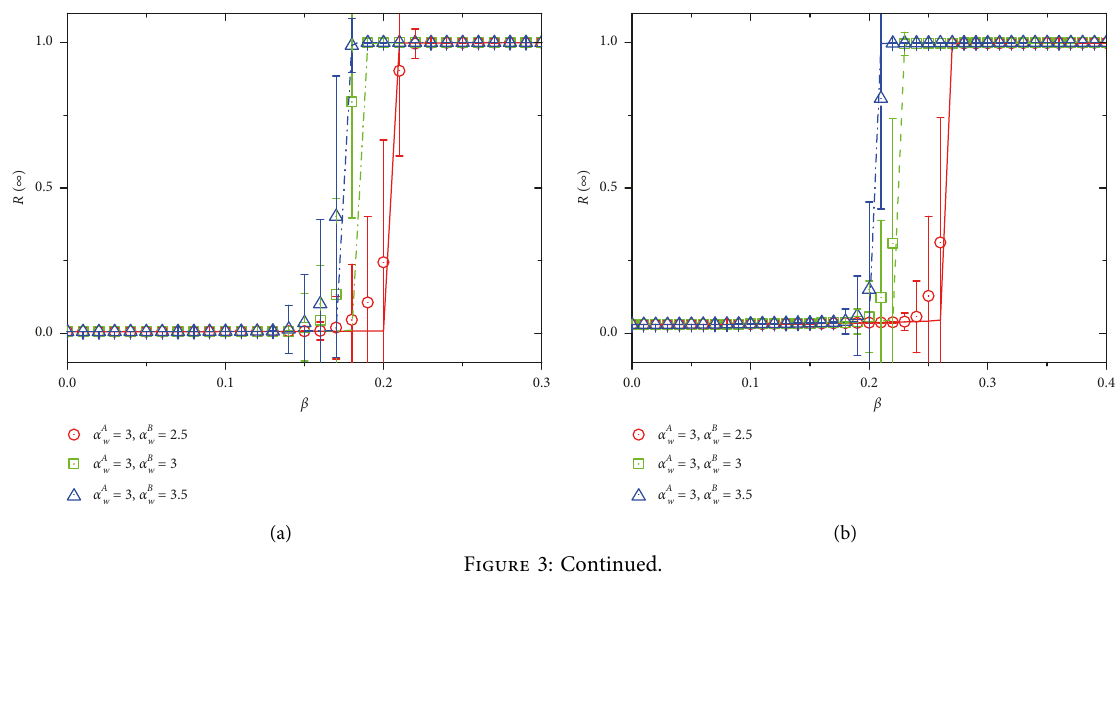
� 3, α B � 2 . 5; α A � 3, α B � 3; ω ω ω ω � 3 , α B � 2 . 5 and α A � 3 , α B � 3. These ω ω ω ω